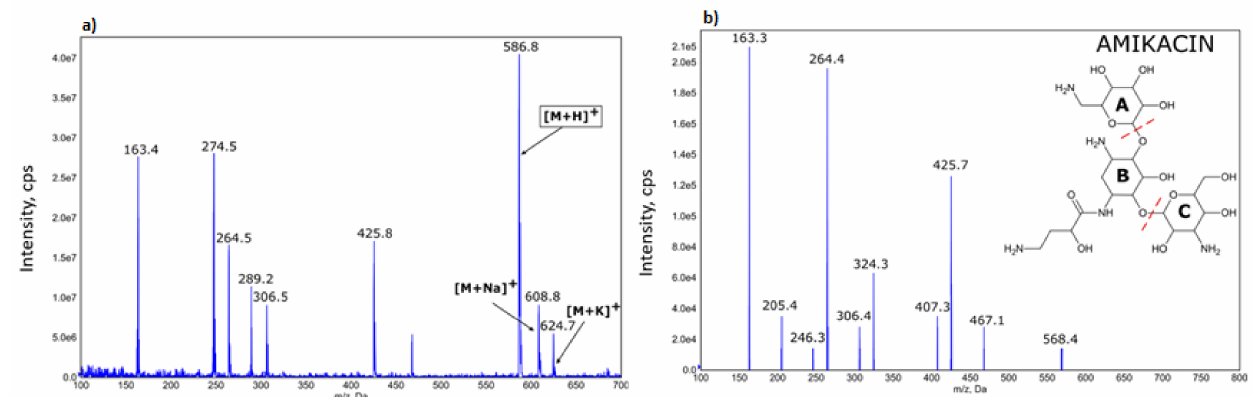
Figure 1. Mass spectrum of amikacin sample ( a )—ion 586.8 m / z represents protonated amikacin and was used in quantitative analysis. Mass spectral fragmentation of amikacin obtained using ESI-MS/MS, positive mode ( b